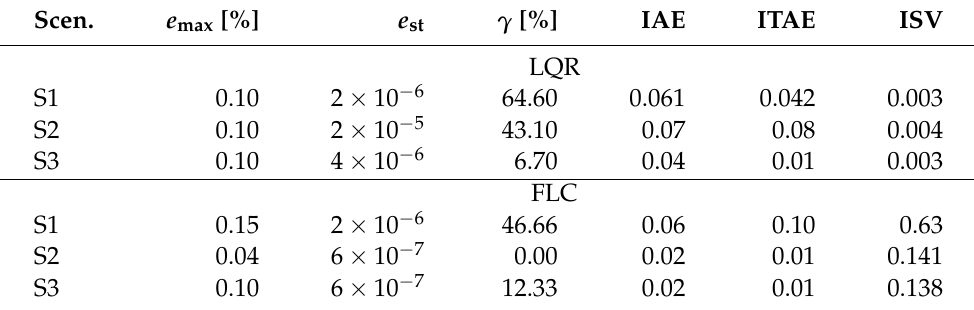
Table 8. Quality indexes of the LQR and FLC—Area 3.